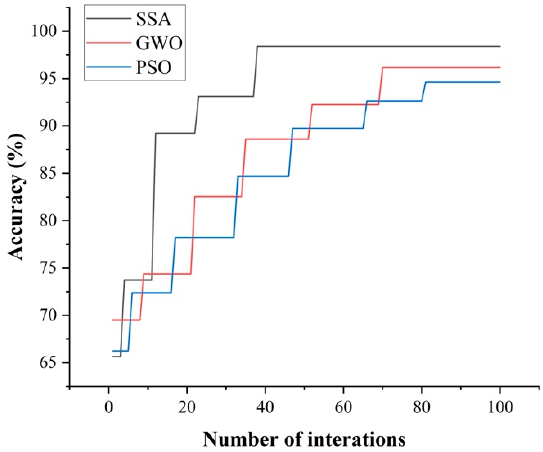
Figure 7. Variation trend of the fitness function curves of SSA, GWO, and PSO with the number of iterations. The SSA-BPNN model reached the optimal state first.